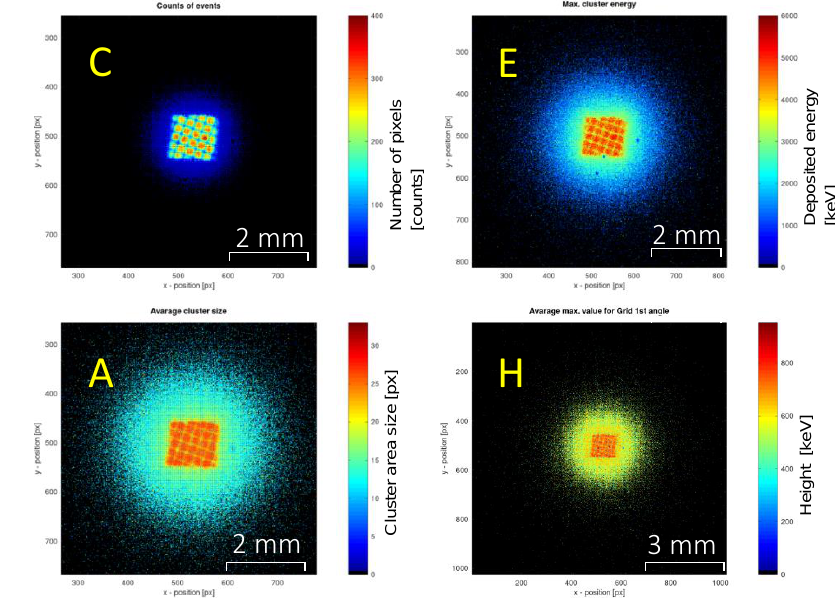
Fig. 5. Similar to Fig. 4 showing proton radiographies of sample G 1 . Images are made from all data (no filtering applied). Image produced with subpixel resolution (one spatial bin corresponds to 13.75 µm)